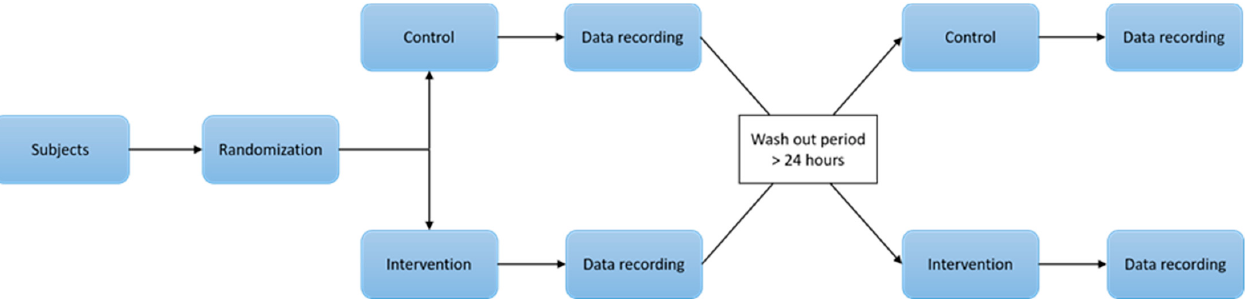
Figure 1. Illustration of the study design.